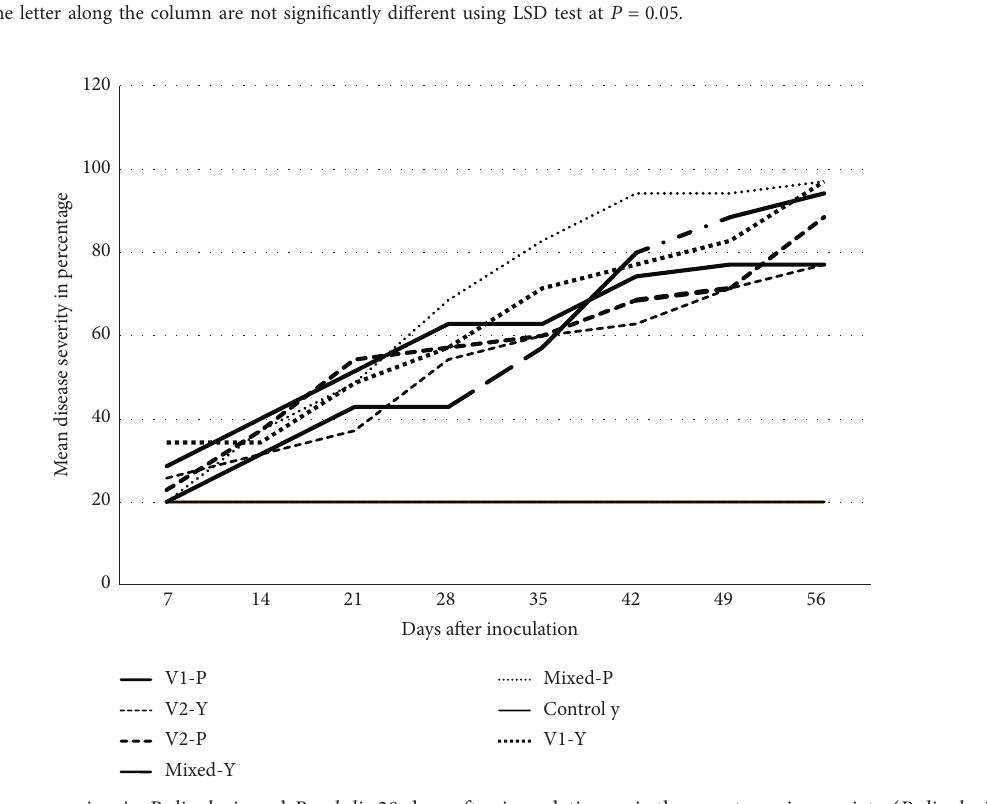
Figure 3: Disease progression in P. ligularis and P. edulis 28 days after inoculation. y is the sweet passion variety ( P. ligularis ), while p represents the P. edulis variety. V1 represents virus isolate 1, V2 is virus isolate 2, and mixed represents a combination of CABMV isolate 1 and CABMV isolate 2. Table 2: Comparison of P. ligularis and P. edulis passion fruit reaction to a mixture of the two virus isolates causing woodiness disease. Variety